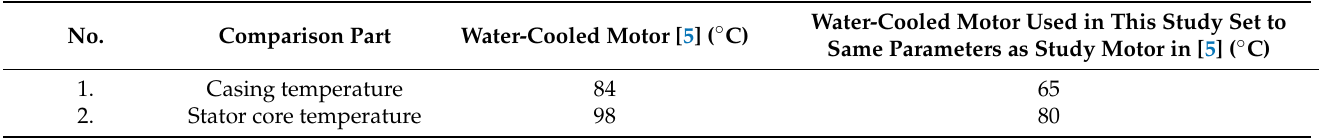
Table 11. Comparison of temperature analyses of two water-cooled motors from a previous study and this study.